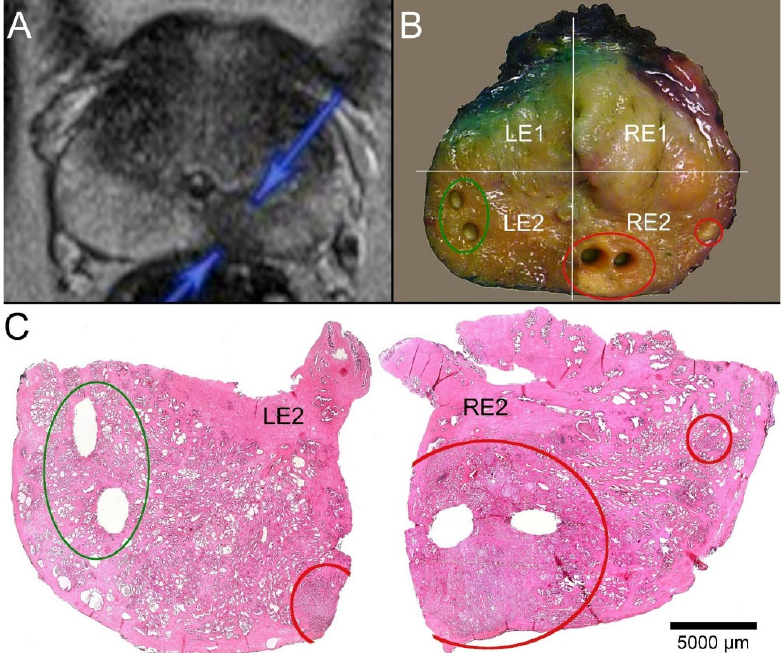
Figure 3. Correlation of MRI imaging, macroscopy, and microscopy. ( A ) T2-weighted MRI of a 59-year-old patient (P32). A round, echo poor PIRADS4 lesion of 11 mm in diameter is marked on the right dorsal peripheral zone (blue arrows). ( B ) Macroscopic dissection of the prostatectomy specimen revealed a slightly brighter lesion in a slice close to the base. A smaller similar focus was visible more laterally. The slice was divided into quadrants (right ventral: RE1, right dorsal: RE2, left ventral LE1, left dorsal LE2). The tumor ‐ suspect foci were localized in the quadrant RE2 (red circles), and the larger lesion was biopsied twice. Another two biopsies representing normal tissue from the contralateral quadrant (green circle) were acquired. ( C ) The paraffin sections of the quadrants LE2 and RE2 showed the sampling localizations of the biobank materials without any doubt. The suspicious foci in RE2 revealed carcinoma infiltrates. The larger tumor focus was represented by the biopsies. The biopsies from the opposite side contained parenchyma free of tumor.